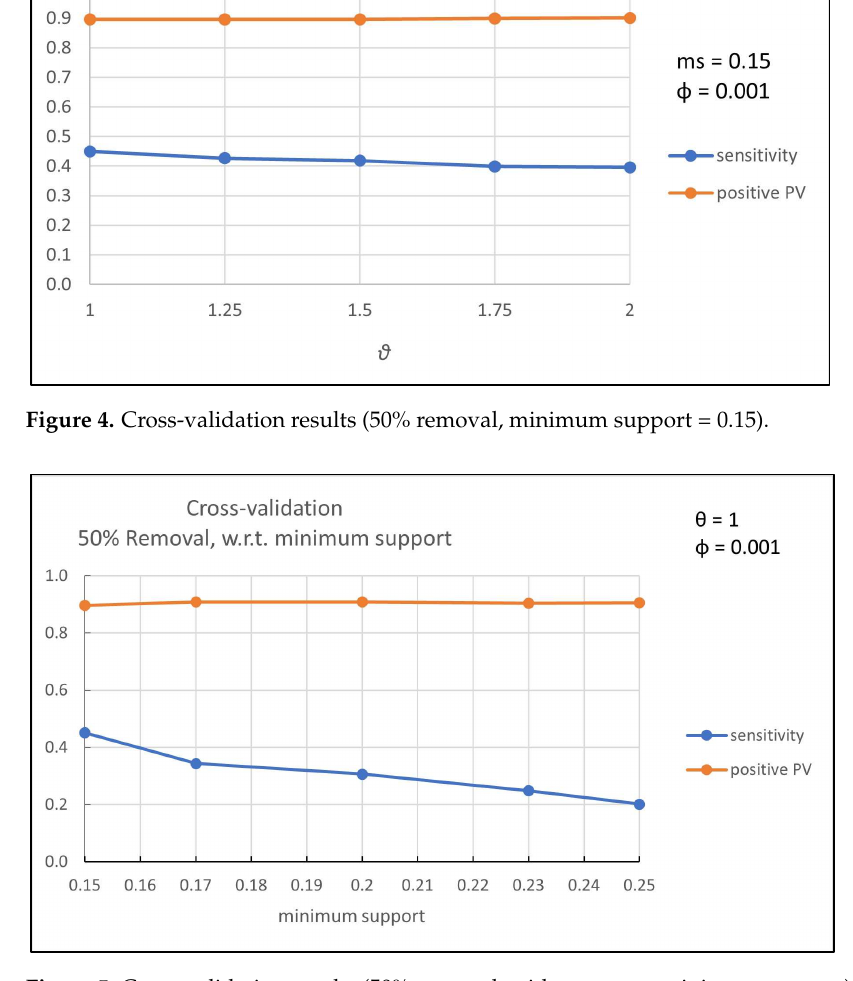
Figure 5. Cross-validation results (50% removal, with respect to minimum support).